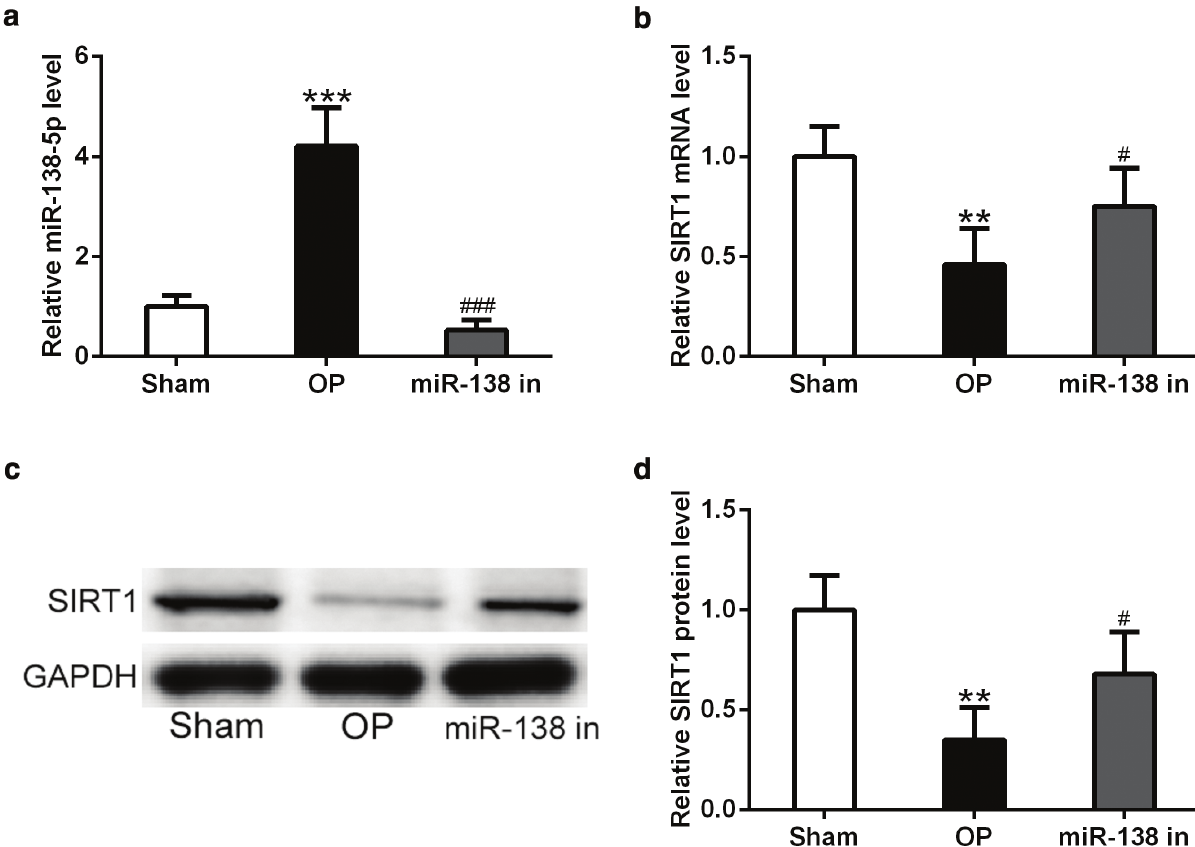
Fig. 5. Inhibition of miR-138-5p increased SIRT1 expression in hippocampus of postoperative cognitive dysfunction (POCD) mice 24 h after surgery. (a, b) qRT-PCR was used to measure the expressions of miR-138-5p (a) and SIRT1 mRNA (b) in hippo- campus of indicated mice. (c) SIRT1 protein expressions were analyzed by Western blotting. GAPDH was employed as a loading control. Relative expressions were normalized to Sham group (d). Sham: C57BL/6 wild-type mice with sham cardiac surgery; OP: C57BL/6 wild-type mice with cardiac surgery. miR-138 in: C57BL/6 wild-type mice with cardiac surgery treated with miR-138-5p inhibitors. Data were presented as ± SD. ** P < 0.01, *** P < 0.001 compared to sham group. # P < 0.05, ### P < 0.001 compared to OP group. n = 8 for each